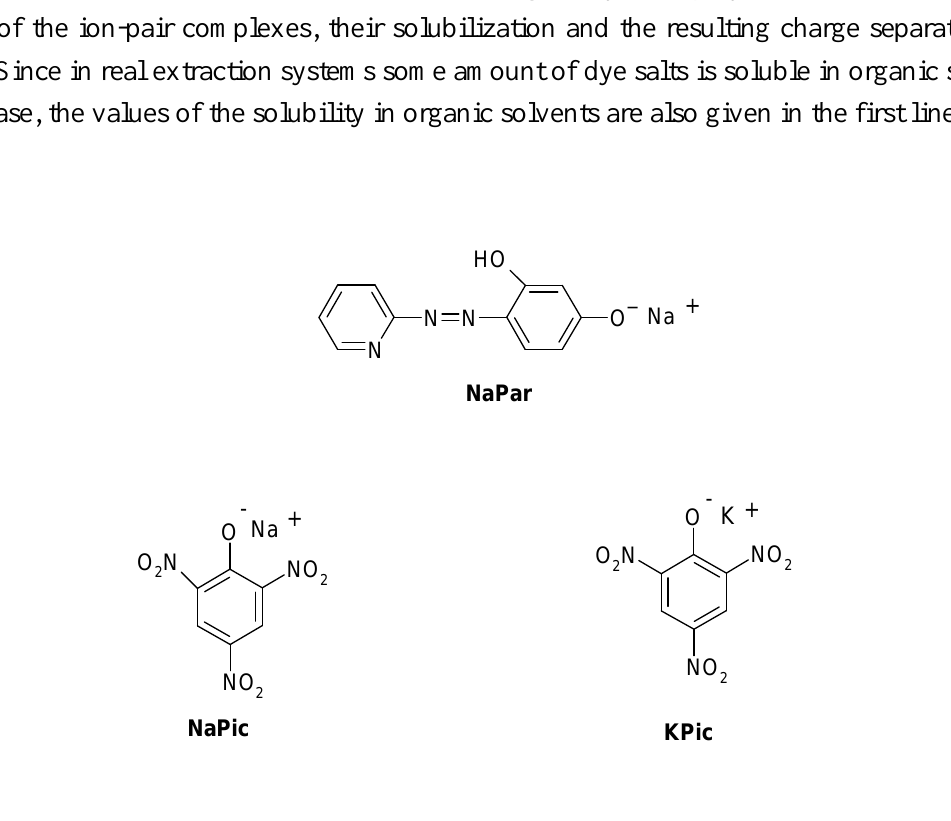
Figure 2. An anionic color compounds of 4-(2-pyridylazo)-resorcinol mono sodium monohydrate (NaPar), sodium picrat (NaPic) and potassium picrat